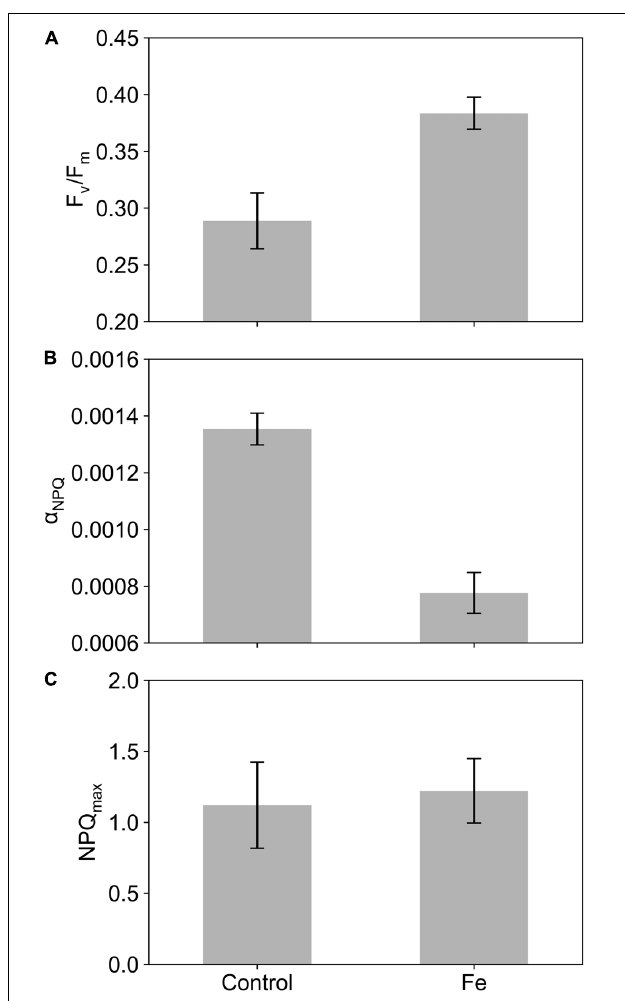
FIGURE 2 | The mean and standard errors of (A) F v /F m , (B) α NPQ , and (C) the maximum NPQ value (NPQ max ) derived from Platt et al. (1980) from the control and iron addition (Fe) treatments of the nutrient addition incubation experiments, excluding measurements after 120 h ( n =